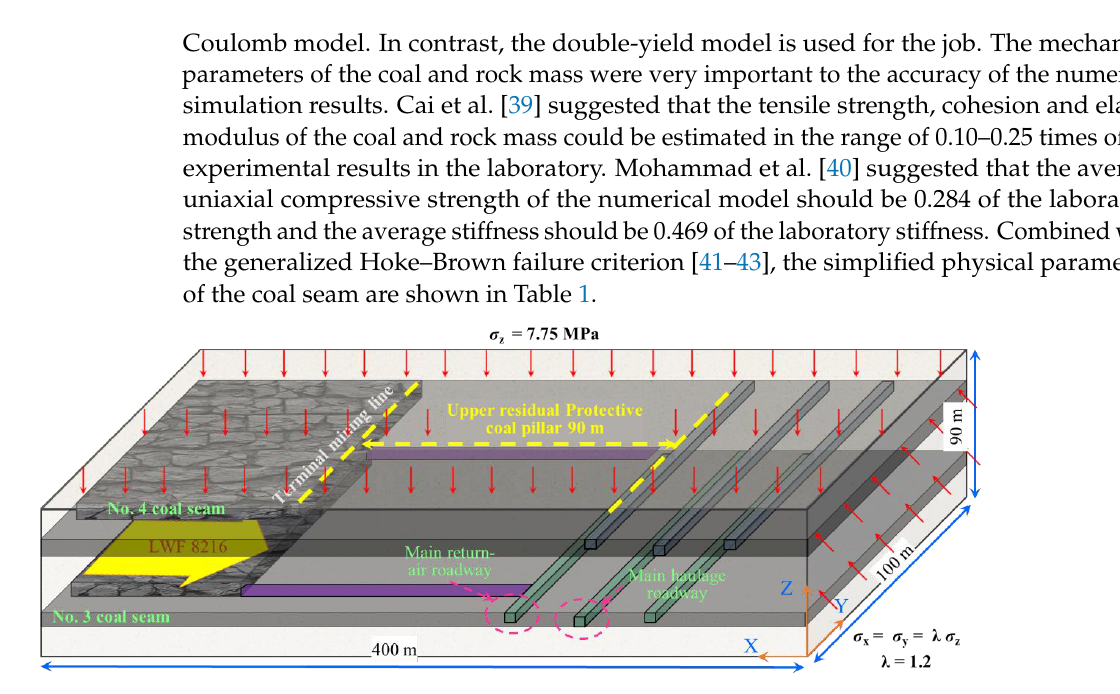
Figure 8. Numerical model overview. Table 1. Properties of the rock mass in LWF 8216.